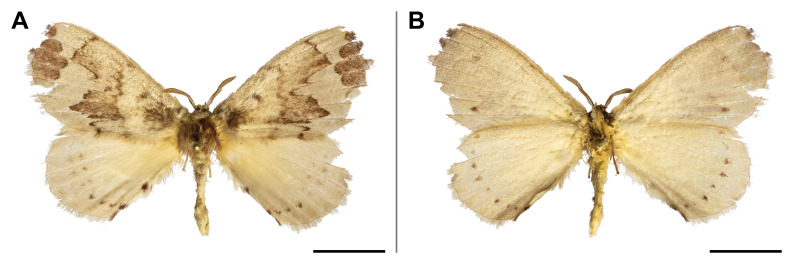
Stenoglene
plagiatus (Aurivillius, 1911). A. dorsal view; B. ventral view. The scale bar represents 1 cm.